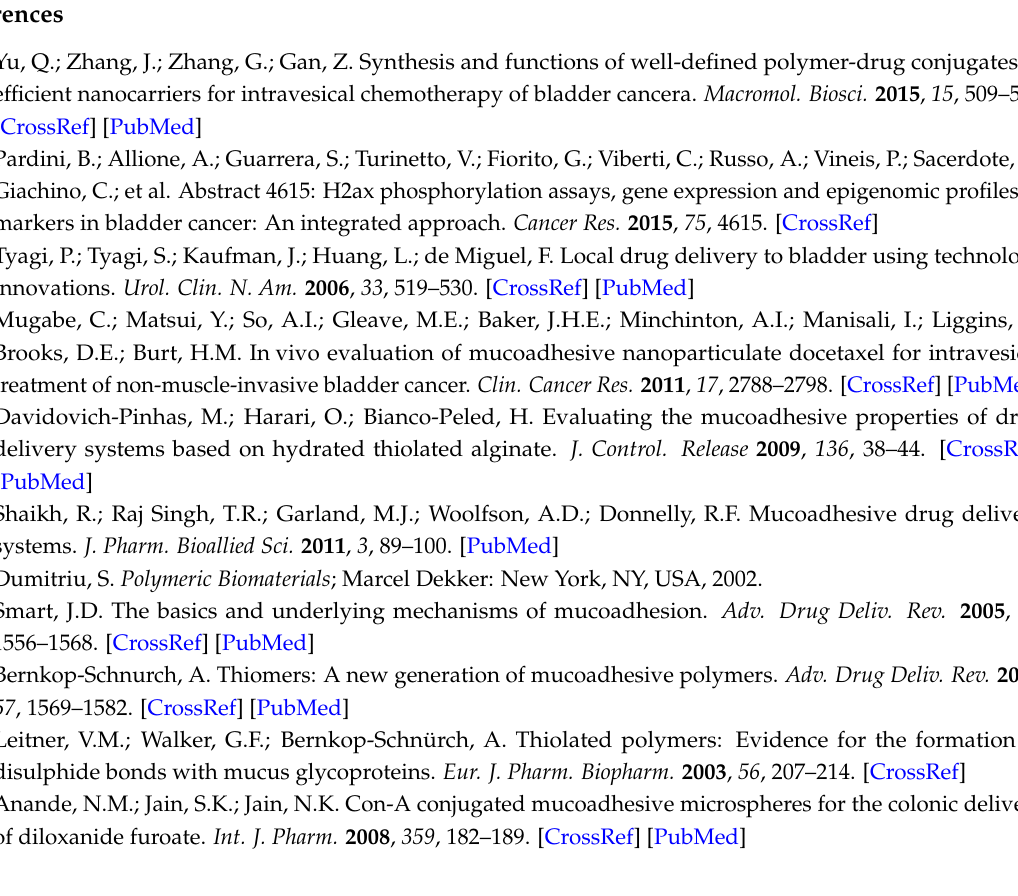
Table S1: Characteristics of the PCL homopolymers and PCL- b -PPFA block copolymers, Figure S1: GPC elution curves of PCL1, PCL2 homopolymers, and PCL1- b -PPFA, PCL2- b -PPFA block copolymers, Figure S2: 1 H NMR spectra of (a) PCL2 homopolymer, (b) PCL2- b -PPFA and (c) PCL2- b -PManEA block copolymers, Figure S3: FT-IR spectra of (a) PCL2 homopolymer, (b) PCL2- b -PPFA and (c) PCL2- b -PManEA block copolymers, Figure S4: 19 F NMR spectra of (a) PCL2- b -PPFA and (b) PCL2- b -PManEA block copolymers, Figure S5: (a,b) Hydrodynamic diameter distribution functions and (c,d) FETEM images of DOX-loaded PCL1- b -PManEA and PCL2- b -PManEA micelles, respectively, Figure S6: Evolution of mean effective diameters of DOX-loaded PCL1- b -PManEA and PCL2- b -PManEA micelles upon binding with